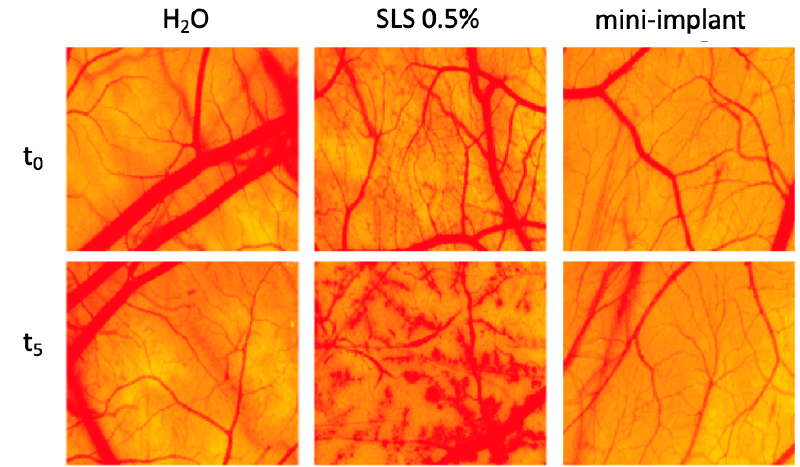
Figure 6. Irritation potential of mini-implant alloy extraction medium on the hen’s egg test on chorioallantoic membrane (HET-CAM) assay—before inoculation of sample / controls (t 0 ) and after five minutes (t 5 ) of contact with test sample / controls. H 2 O was used as negative control and sodium laurylsulphate (SLS) 0.5% was employed as positive control.